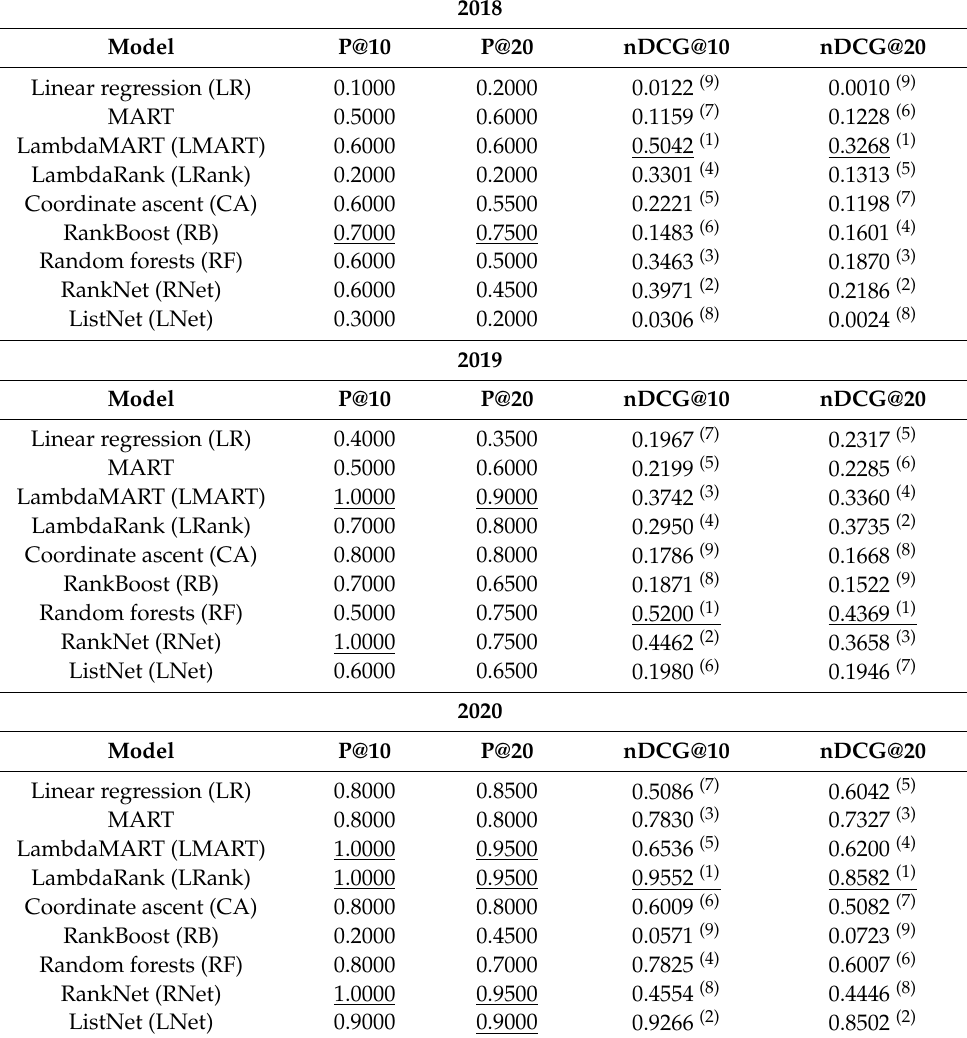
Table 4. The ranking performance results for applying nine LtR models to predict the top stocks in Saudi Exchange for four years, 2018, 2019, 2020, and 2021. Underlined values represent the models with the highest effectiveness for a metric. Superscript numerals in parentheses represent the rank of a model among all models using